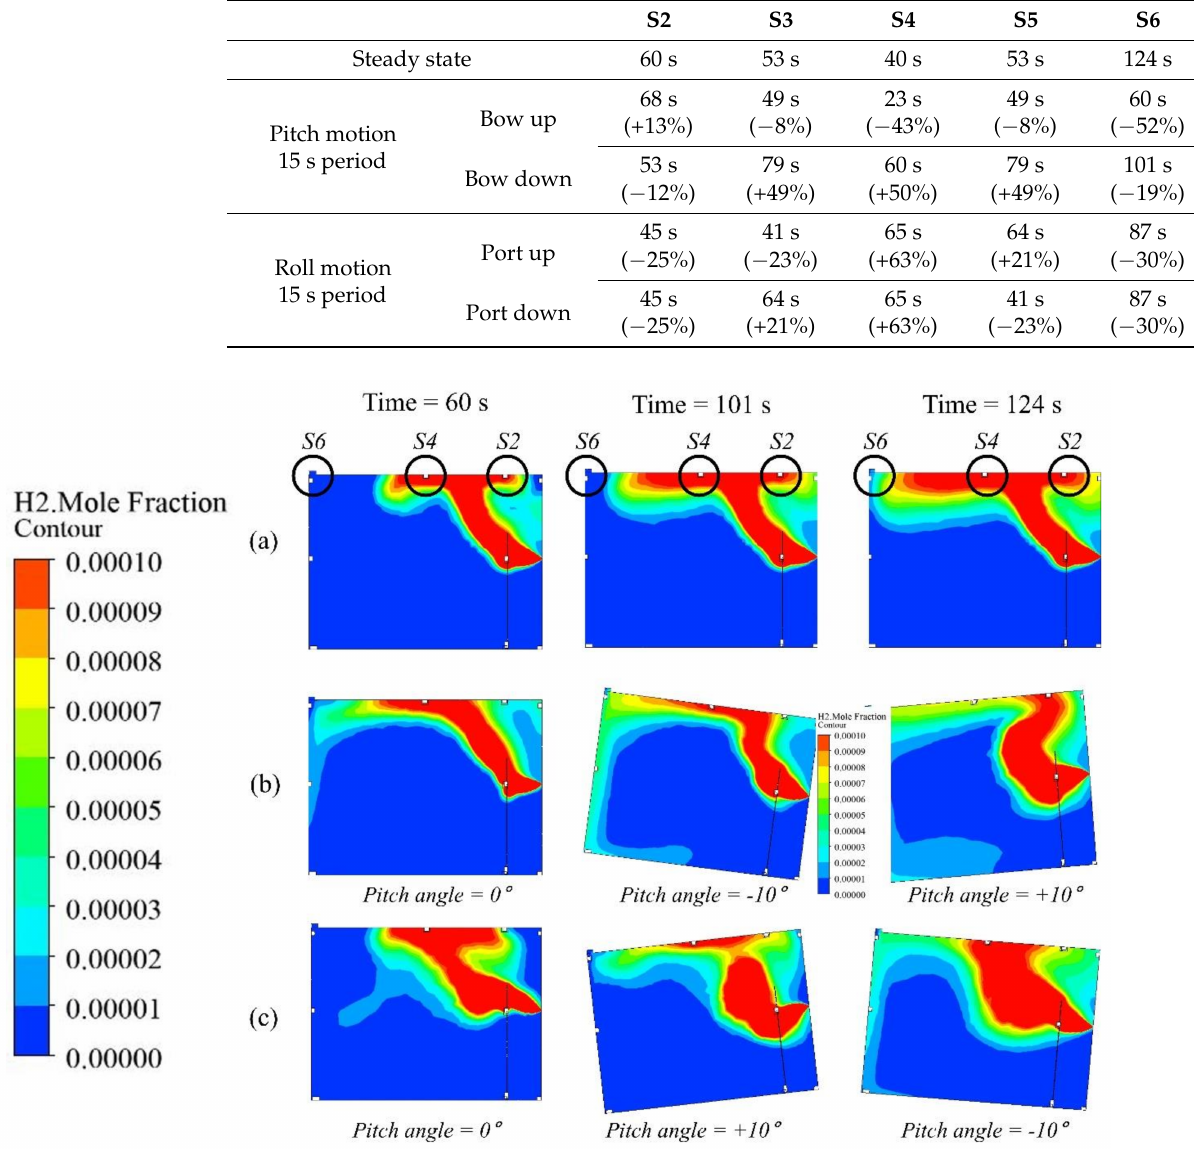
Figure 11. Central longitudinal cross-section of hydrogen distribution: ( a ) Steady state; ( b ) Pitching to bow up; ( c ) Pitching to bow